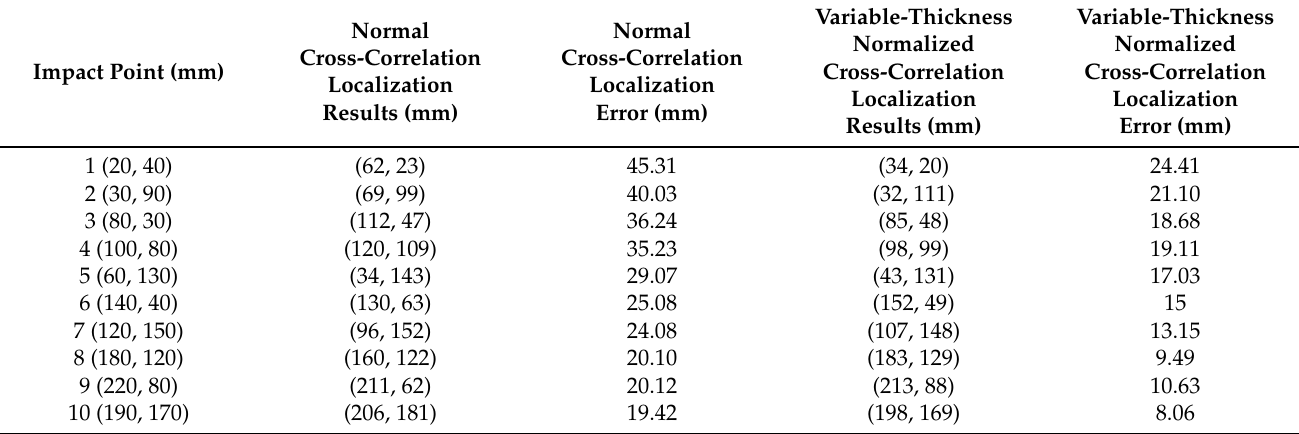
Table 3. The localization results of 10 verification